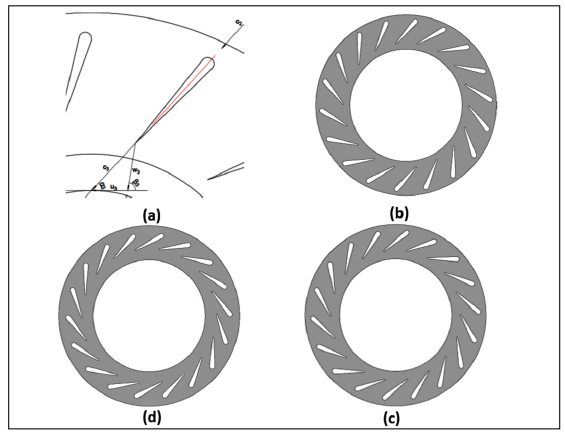
Figure 5. The positions of the VTG of the 2nd stage turbine wheel: ( a ) blade configuration